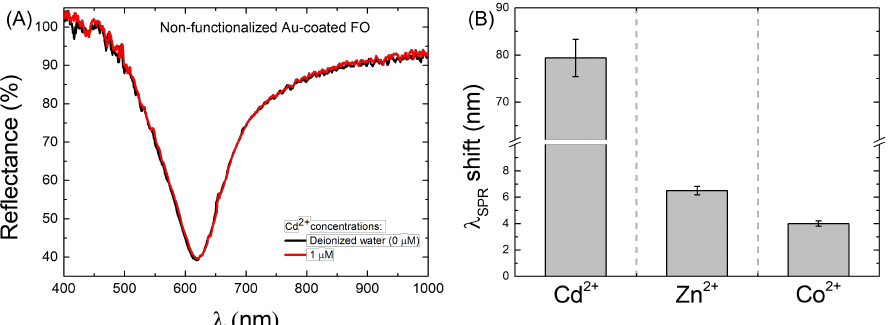
Figure 2. FO-SPR sensor specificity measurements. ( A ) Control test, showing that, in the absence of any Cd 2 + -sensitive layer on the Au-coated sensor, only an SPR wavelength shift of ∼ 2 nm is recorded for the 1 µ M Cd 2 + solution. ( B ) Evaluation of the BSA/Au-coated FO-SPR sensor’s selectivity for detection of 1 µ M Cd 2 + , Zn 2 + , and Co 2 + metal ions, respectively, in aqueous solutions. The error bars represent standard deviation ( n = 3).